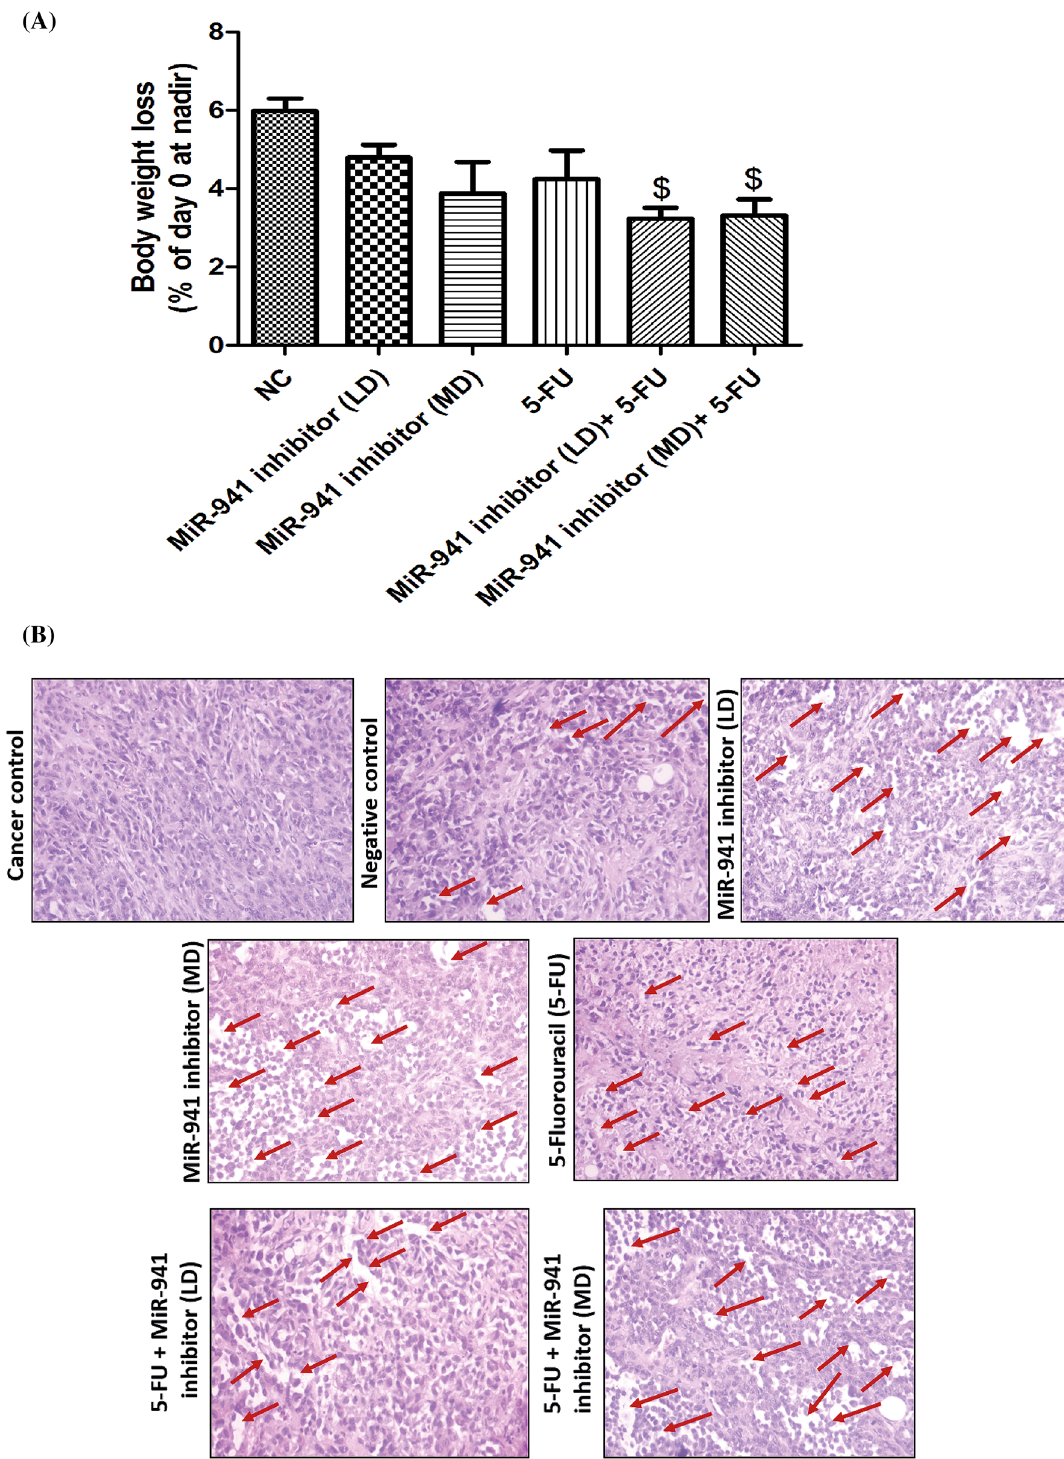
Figure 7. MiRNA-941 inhibitor and 5-FU combination exhibit high efficacy and low toxic effects in MDA-MB-231 xenograft model of nude mice. ( A ) Body weight loss of animals after dosing of animals: BWL was calculated after 4 weeks of treatment. ( B ) Histopathological analysis of tumours excised from (a) cancer control (b) negative control (scrambled miRNA sequence) (c) MiR-941 inhibitor (LD = 1 µM), (d) MiR-941 inhibitor (MD = 2 µM), (e) 25 µM 5-fluorouracil (5-FU), (f) 5-fluorouracil + MiR-941 inhibitor (LD) and (g) 5-fluorouracil + MiR-941 inhibitor (MD) treated animals. The arrows depict the interstitial spaces in tumour samples. No such significant spaces were found in tumours of untreated animals. All values were expressed as mean ± S.E.M. $ p < 0.05 significant vs Negative control